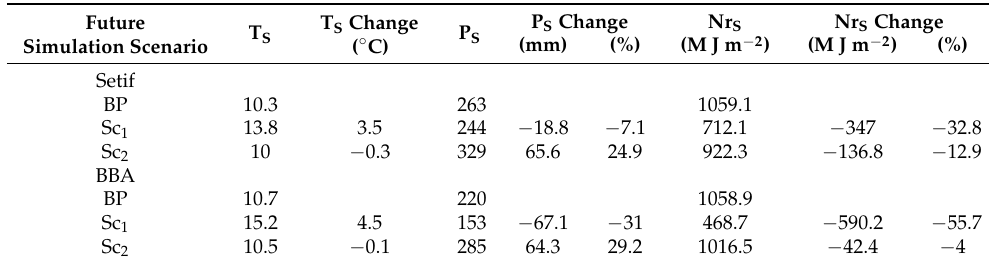
Table 3. Comparison of the thirty years averages of T S , P S , Nr S between the BP and the futurescenarios Sc 1 and Sc 2